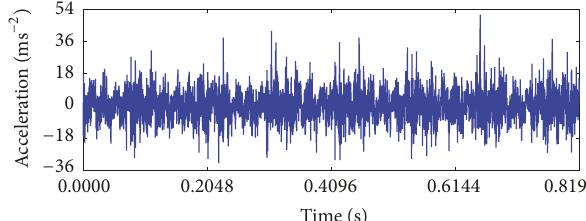
Figure 19: The vibration signal measured from the axle box of running high-speed train.